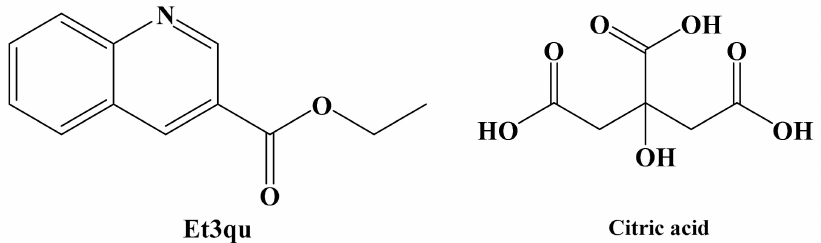
Figure 1. Structures of the studied